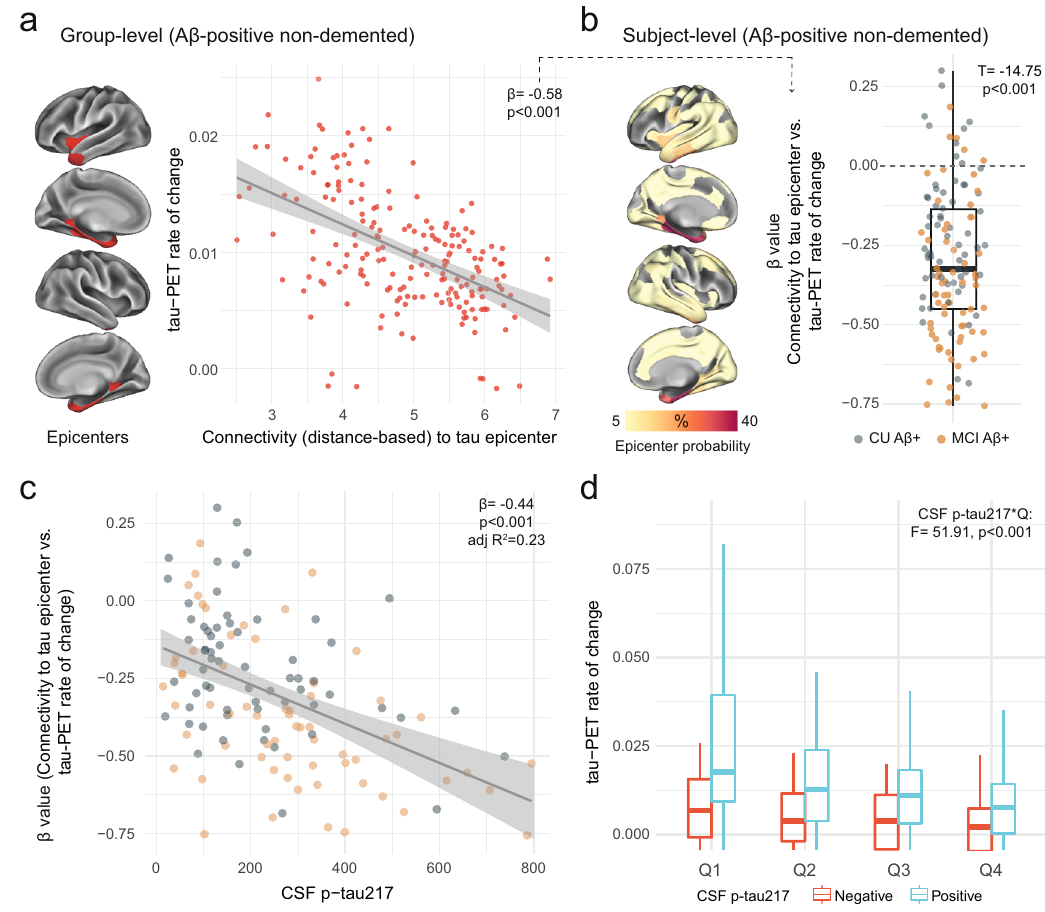
Fig. 3 | Individualized connectivity-based associations of tau-PET rate of changeovertimeand CSF p-tau217 inA β -positive non-dementedparticipants. a Group-level analysis showing how connectivity to the tau epicenters (projected on the glass brains) relates to tau-PET rate of change across the whole brain. Each dotrepresentsabrainregion.Regionsmorestronglyfunctionallyconnectedtothe epicenters have greater rate of tau-PET accumulation. b Repeating the same approach depicted in a at the individual level, the values on the glass brains representthepercentagethateachregionisclassi fi edasanepicenter.Theboxplot showstheindividual β -value( n =130)fromthecorrelationbetweentau-PETrateof change and connectivity-based distance to epicenters across all brain regions. c Scatter plot of the associations between CSF p-tau217 and the β -values of